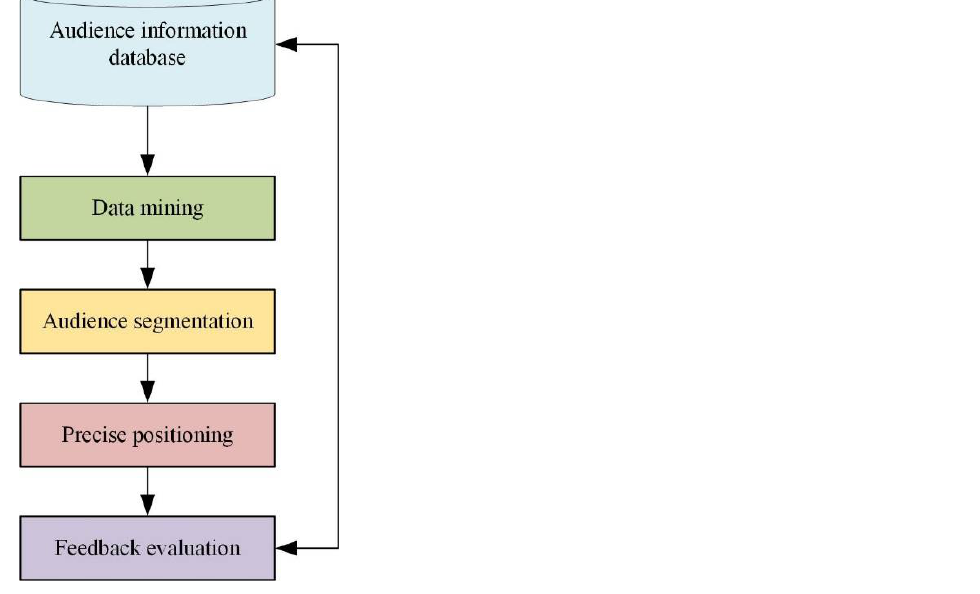
Figure 5. The process of precise positioning of big data (drawn from research analysis after reviewing the data).